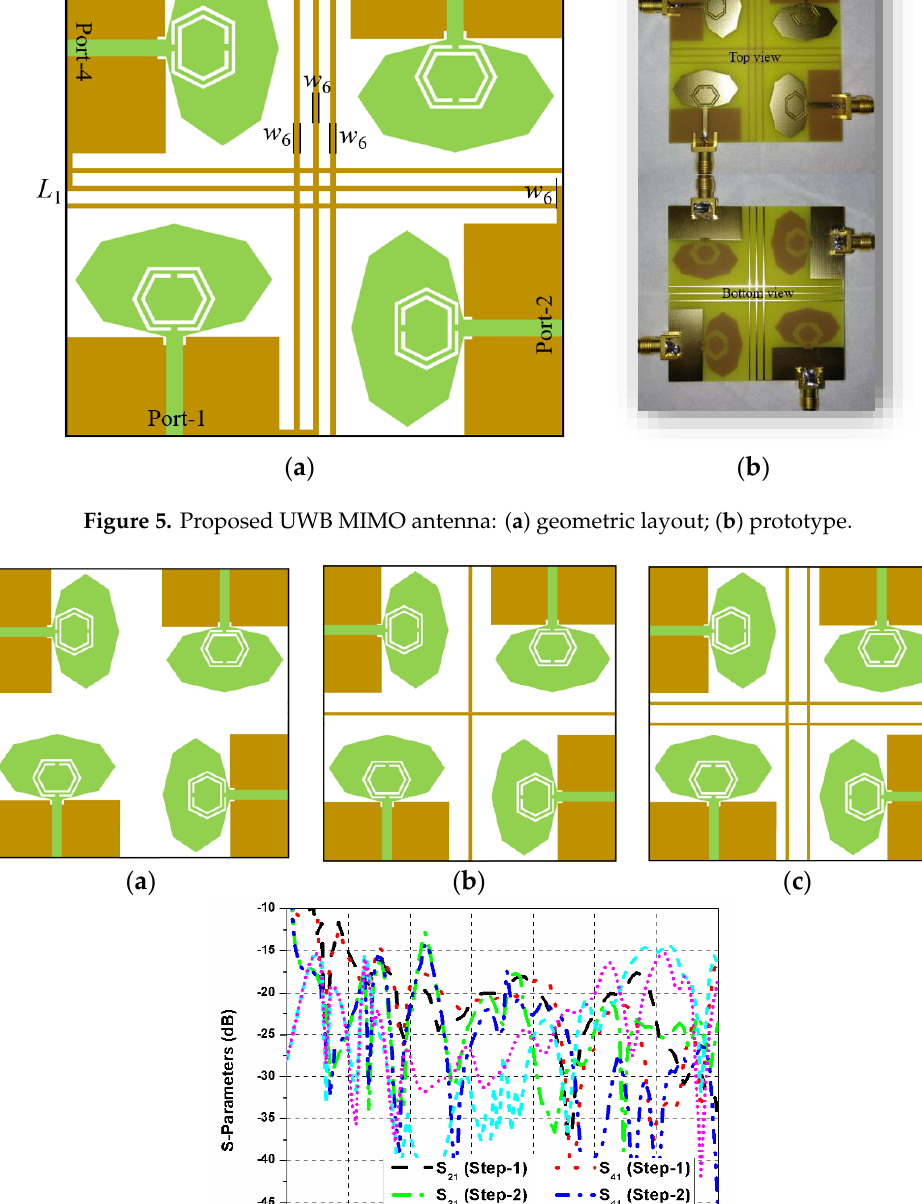
Figure 5. Proposed UWB MIMO antenna: ( a ) geometric layout; ( b ) prototype.